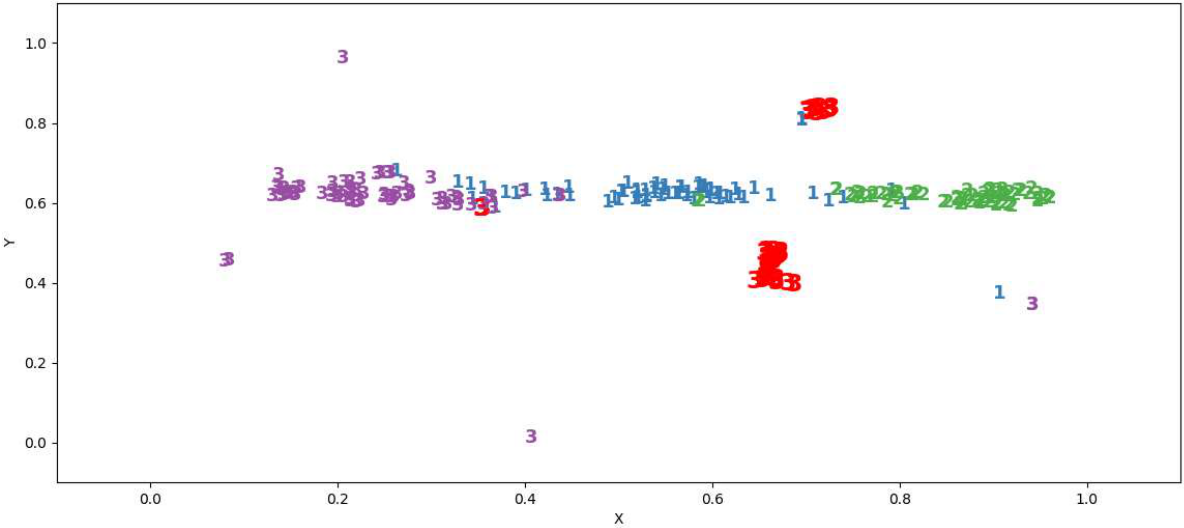
Figure 13. Successful adversarial attacks on the EnAE classifier (highlighted in red).